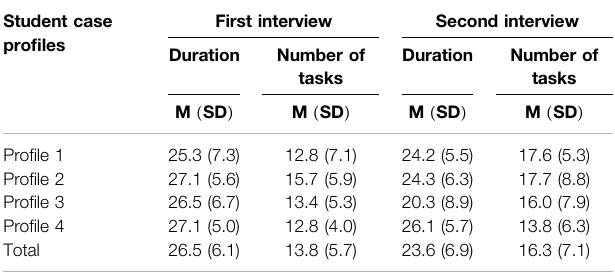
TABLE 1 | Item statistics. TABLE 2 | Descriptive statistics for interviews: Mean values (M) and standard deviation (SD) of interview duration [in minutes] and number of selected tasks for each interview and student case pro fi